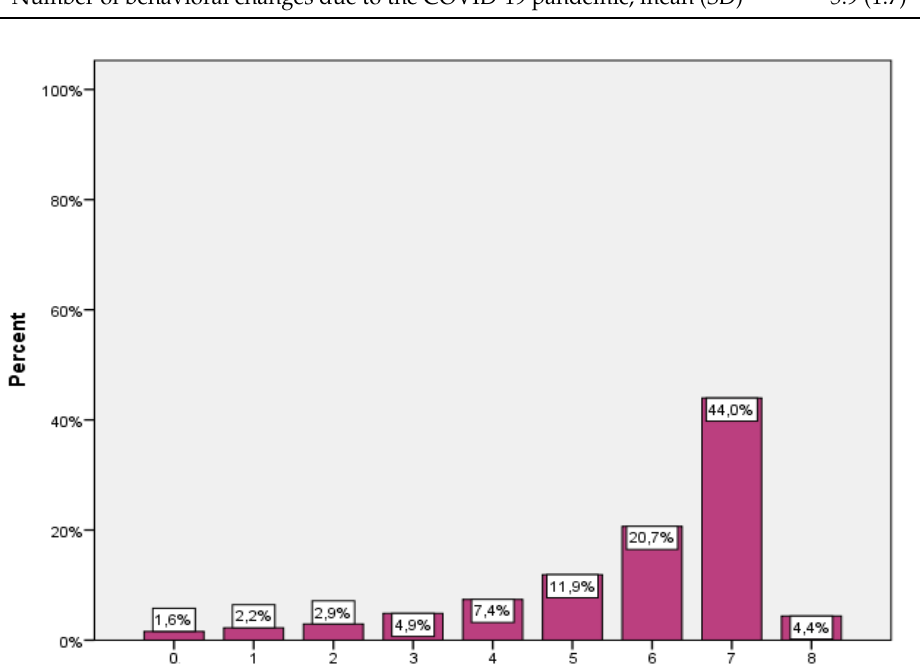
Figure 1. The number of behavioral changes due to the COVID-19 pandemic. The number of behavioral changes due to the COVID-19 pandemic.